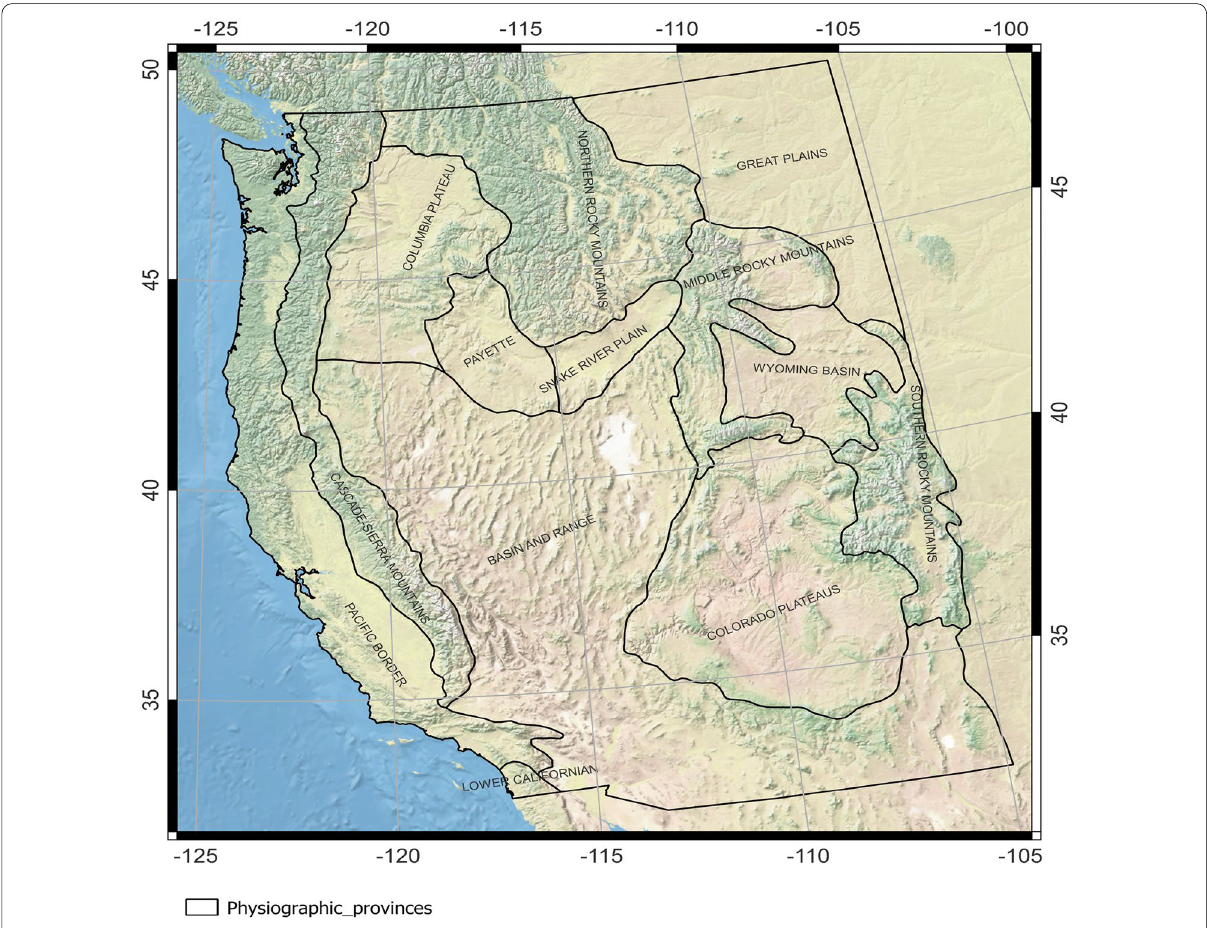
Fig. 2 Location map of the study area, western